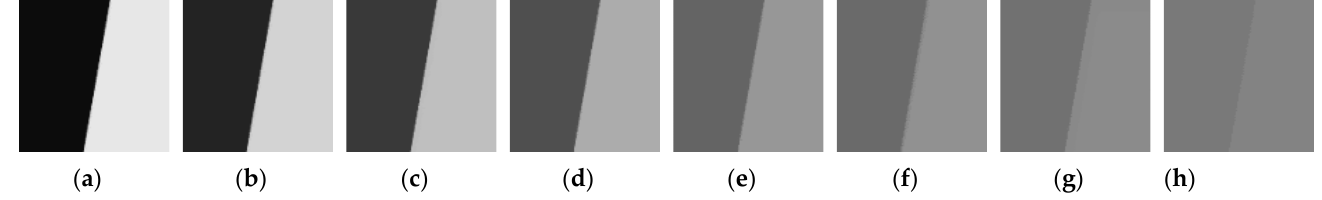
Figure 3. Partial simulated BDE@Con images with different contrasts when edge angle is 10 deg: ( a ) the contrast is 0.84, ( b ) the contrast is 0.68, ( c ) the contrast is 0.52, ( d ) the contrast is 0.36, ( e ) the contrast is 0.20, ( f ) the contrast is 0.15, ( g ) the contrast is 0.10, ( h ) the contrast is 0.04.